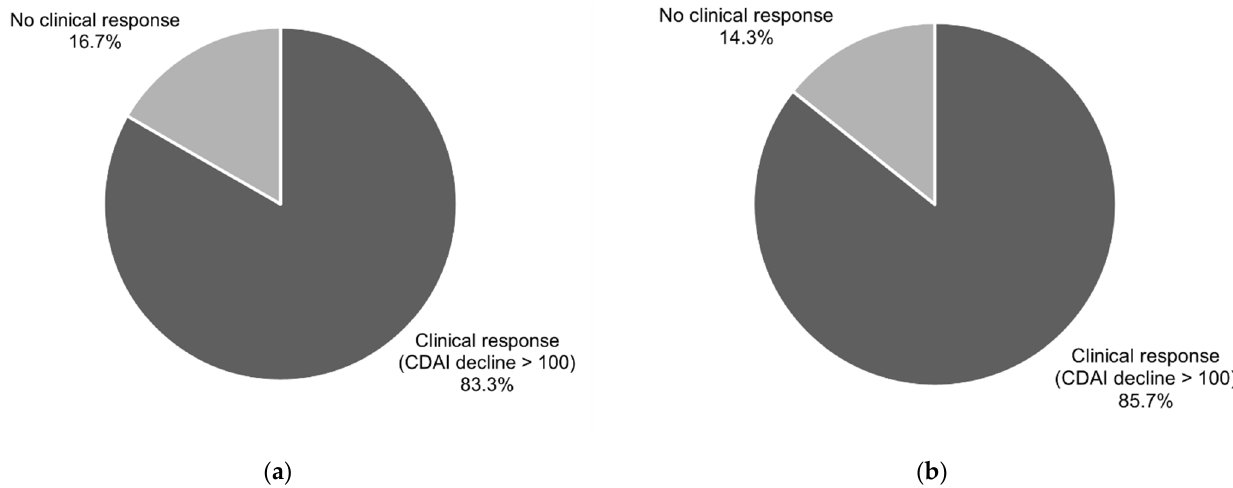
Figure 2. Clinical response (reduction in CDAI > 100 points) in patients after 6 ( a ) and after 12 ( b ) weeks of CDED.